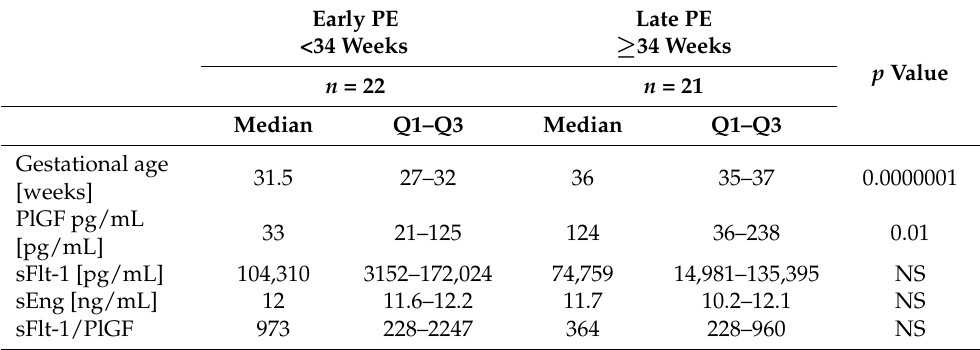
Table 9. Comparison of the results in early and late PE.